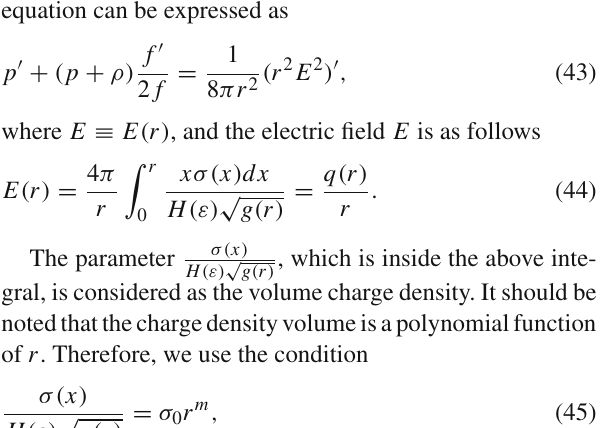
= 10, C = 1, p = 1, and B = 1 1 2 0